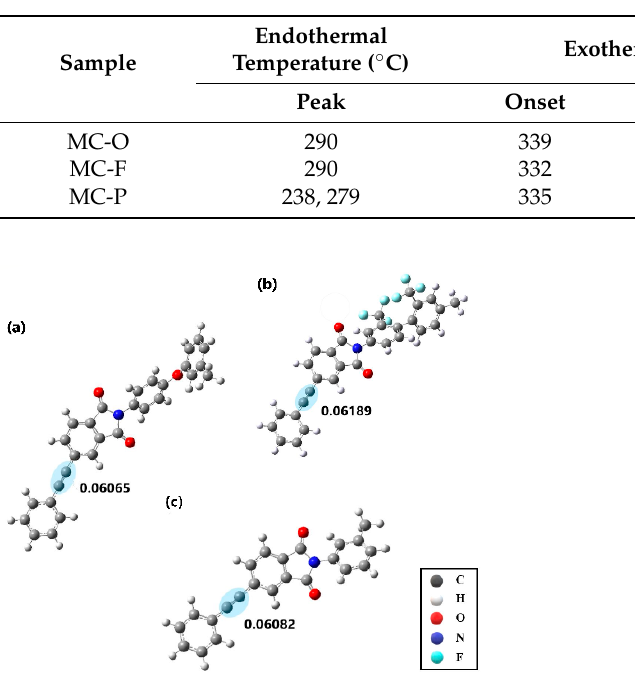
Figure 13. DSC curves of the model compounds. Table 5. Thermal data of the model compounds.